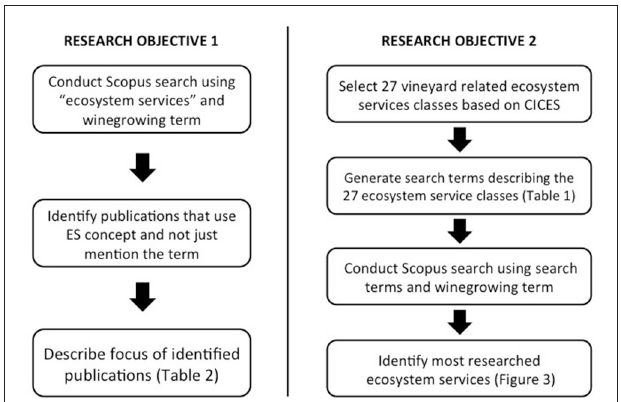
FIGURE 2 | Overview of the research process for the first and second research objective. The first search looked for publications focused on applying the ecosystem services concept in vineyard landscapes by searching for a combination of the term “ecosystem services” and winegrowing terms (e.g., “vineyard*,” “viticulture*,” “wine,” “grape* grow*,” “wine* grow”), identifying seven papers that specifically focused on vineyard ecosystem services, which were described in Table 2 . The second search looked for publications researching single ecosystem services by operationalizing 27 CICES ecosystem services classes for vineyards (shown in Table 1 ) and generating search terms for each ecosystem service in order to conduct a literature search for peer-reviewed publications to identify the most researched ecosystem services (shown in Figure 3